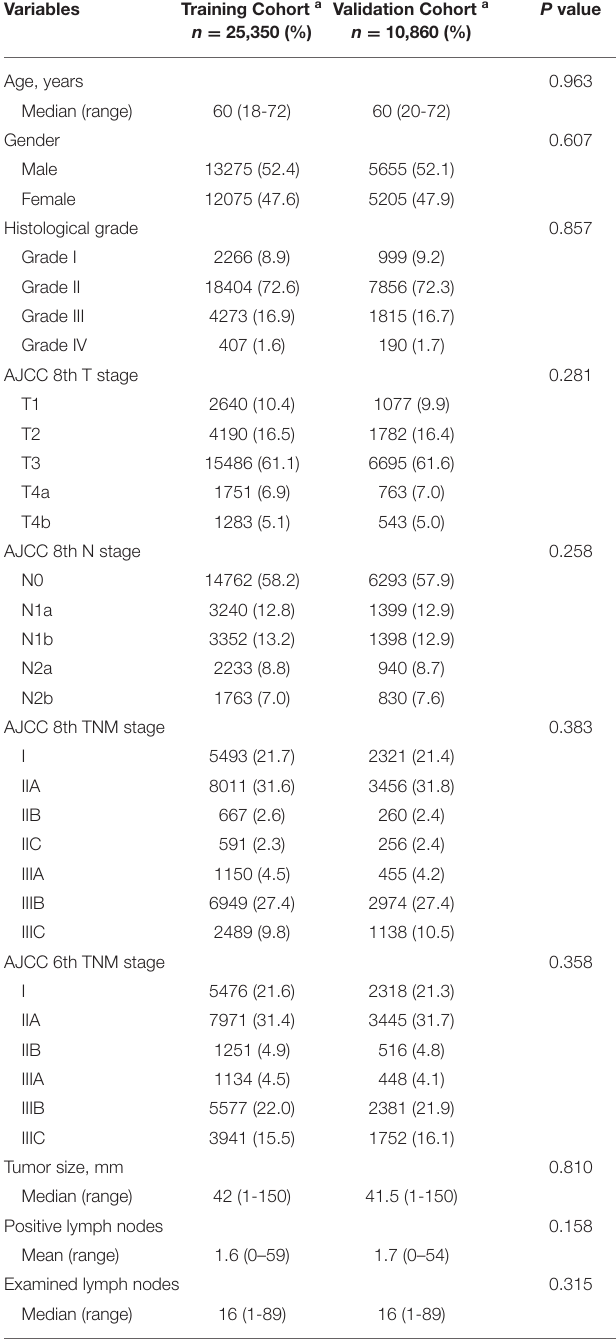
TABLE 1 | Baseline characteristics of training and validation